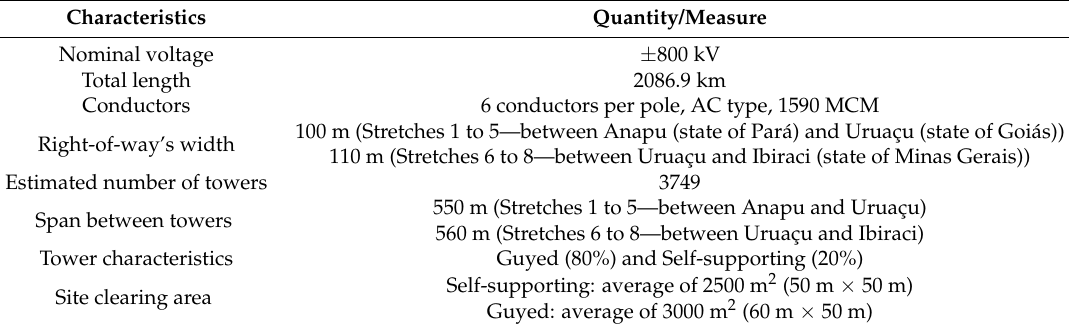
Table 2. Constructive characteristics Xingu - Estreito line. Adapted from [16].